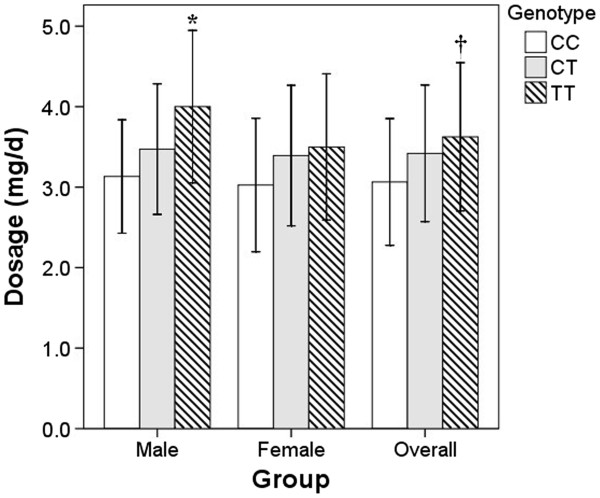
The effect of CYP4F2 genotype to the male, female and overall patients warfarin dosage. *P < 0.05 vs CC after adjusting for age, gender and weight and Bonferroni correction. †P < 0.05 vs CC after adjusting for age and weight and Bonferroni correction.